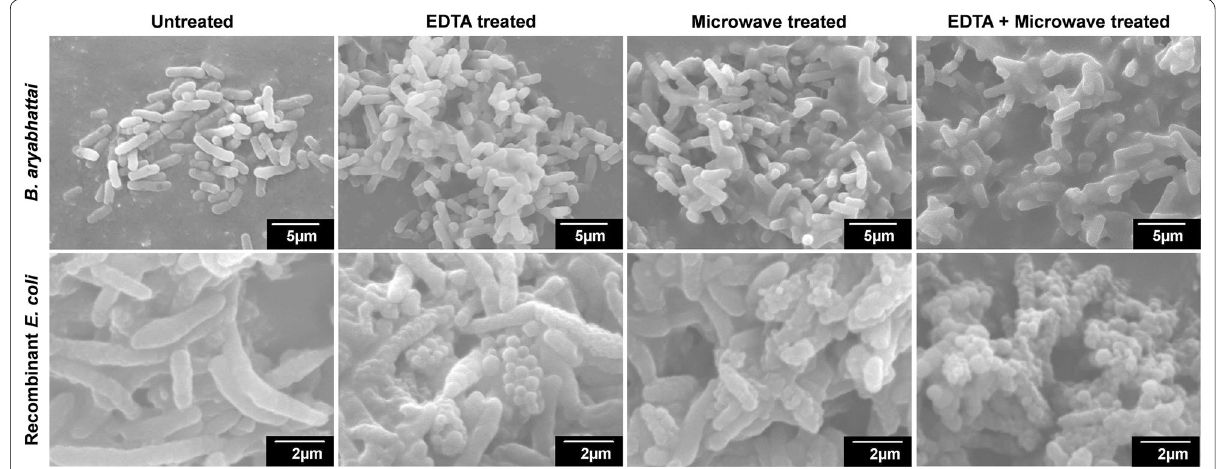
Fig. 7 SEM images depicting the effect of EDT and microwave on cell morphology (magnification: B. aryabhattai — coli — 5000) ×